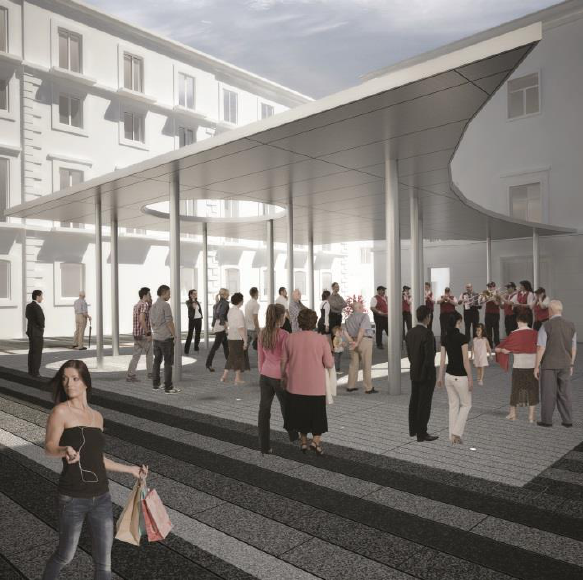
Figure 2. A rendering view of a curved side and the big circular hole inside the steel canopy (Courtesy of Giustino Vallese and Dario Magnacca)